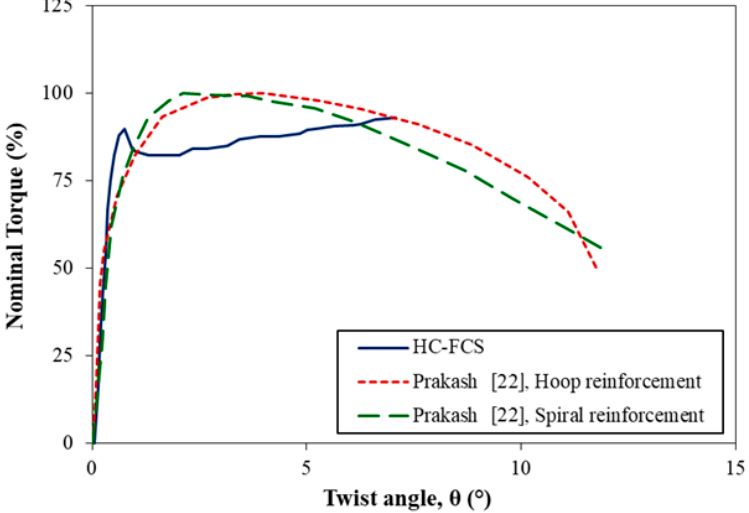
Figure 13. Comparison of a HC-FCS column and a reinforced concrete column reproduced from Prakash [22]